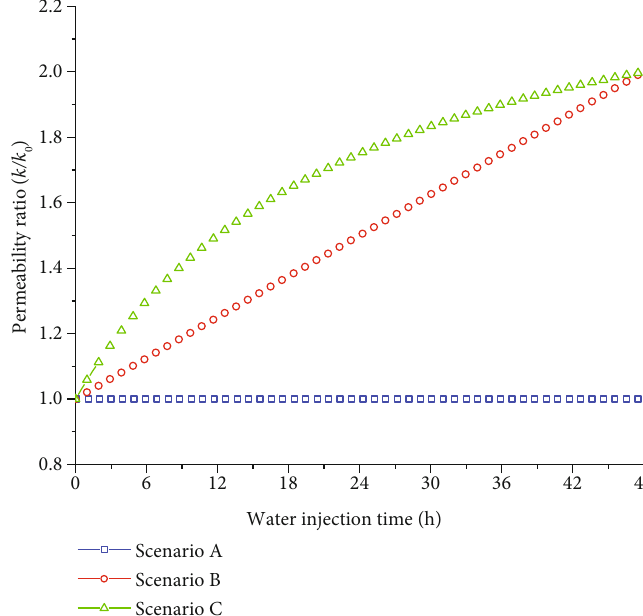
Figure 13: Intrinsic permeability variations with injection time.